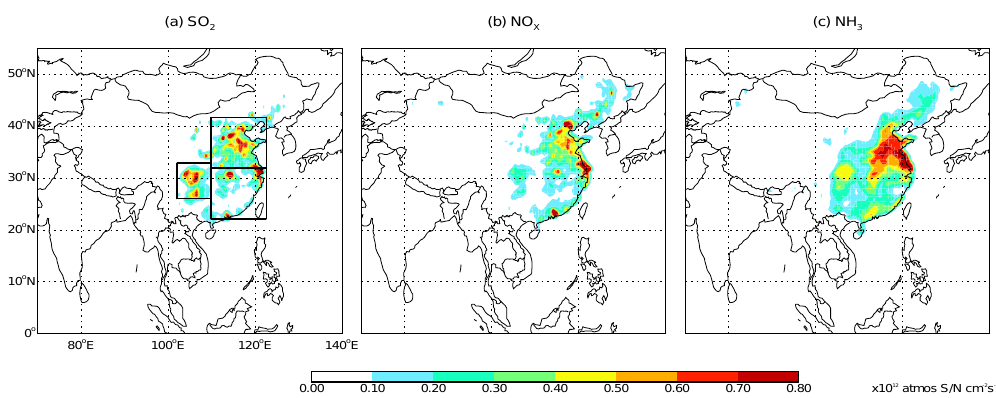
Fig. 1. Spatial distributions of (a) SO 2 , (b) NO x and (c) NH 3 emissions from China used in the 2006C simulation. Please note that this figure is not the whole East Asian model domain, which is shown in Fig. 3, and that emissions outside of China are omitted. The rectangles in (a) represent North China (upper right), South China (lower right), and the Sichuan Basin (left). (a) SO 2